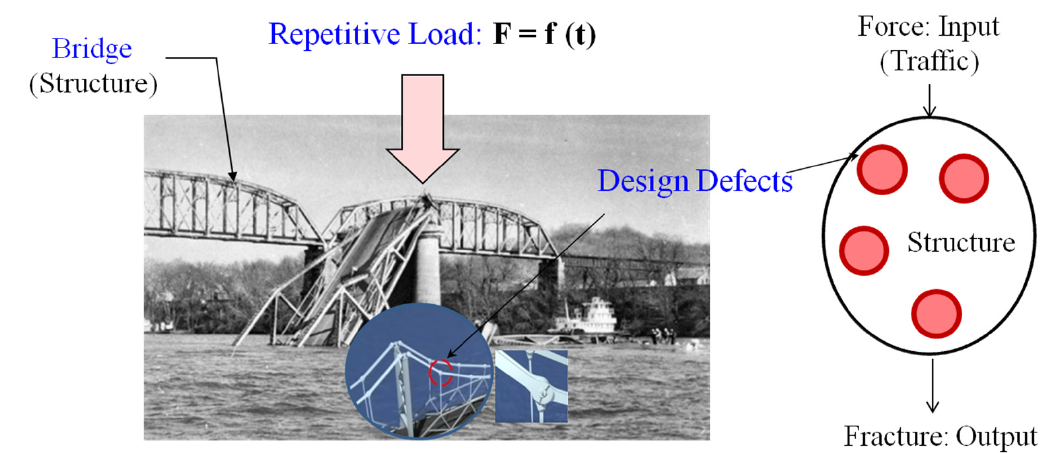
Figure 4. Fatigue failure on the product produced by (random) repeated load and design flaws.